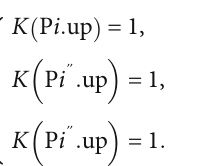
Figure 5: The model of a load-sharing architecture with two